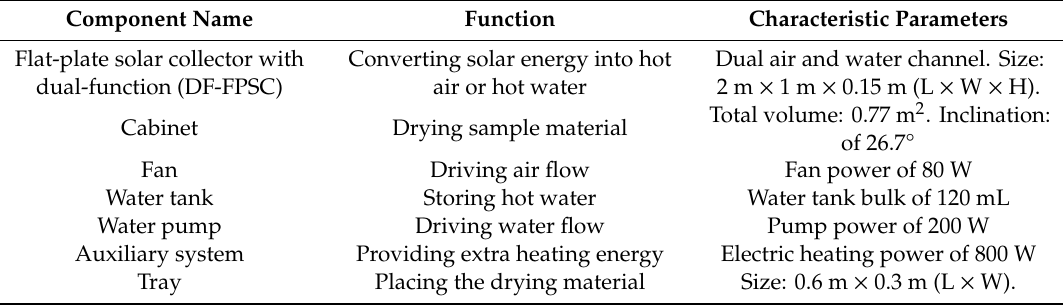
Figure 2. Photograph of hybrid solar dryer. Table 1. The system composition characteristic parameters.